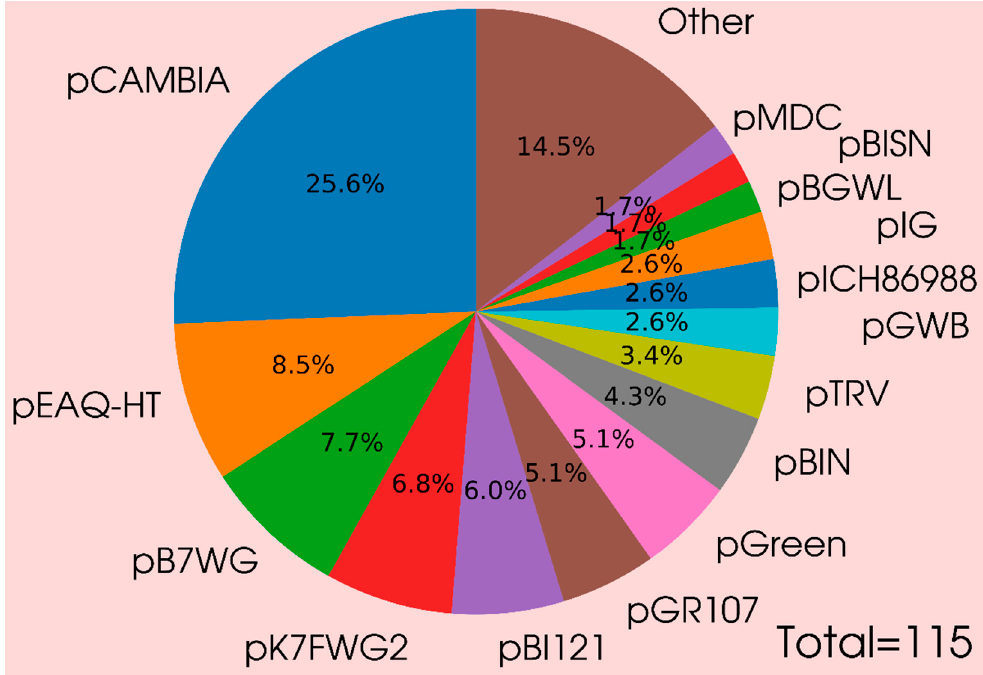
Figure 5. Usage of vectors in transient gene expression in plants. The percentage of vectors usage in transient gene expression in plants is calculated based on scientific articles (Supplemental Table S2).